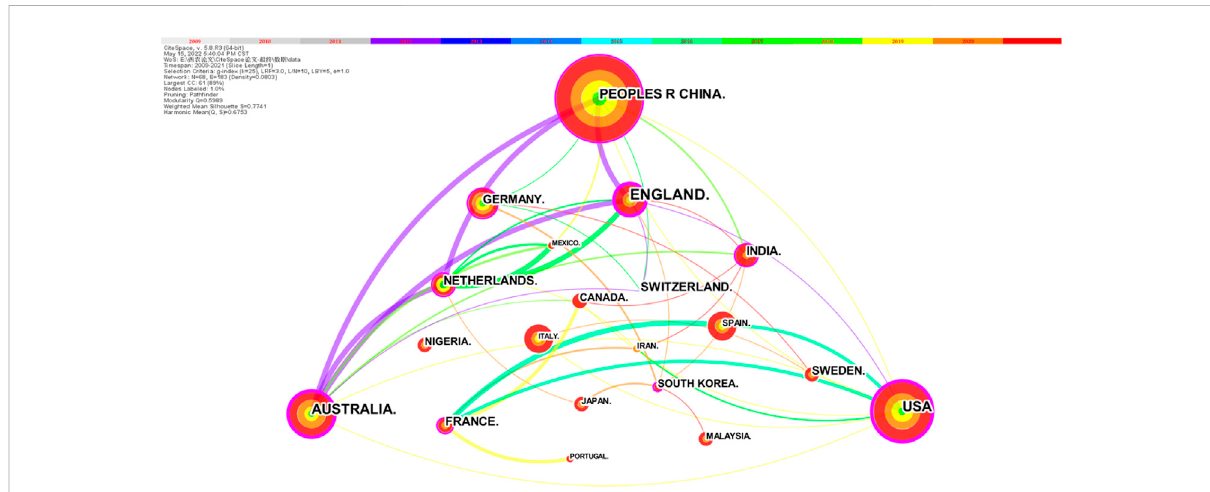
FIGURE 5 Country/Regioncooperationknowledgegraph.(Nodesrepresent country/region.Thesizeofanodeisproportionaltotheliteraturenumberof the country/region. The links represent the co-occurring relationship between different subject categories. The color of the rings and links corresponds to the year. The purple rings indicate high centrality).